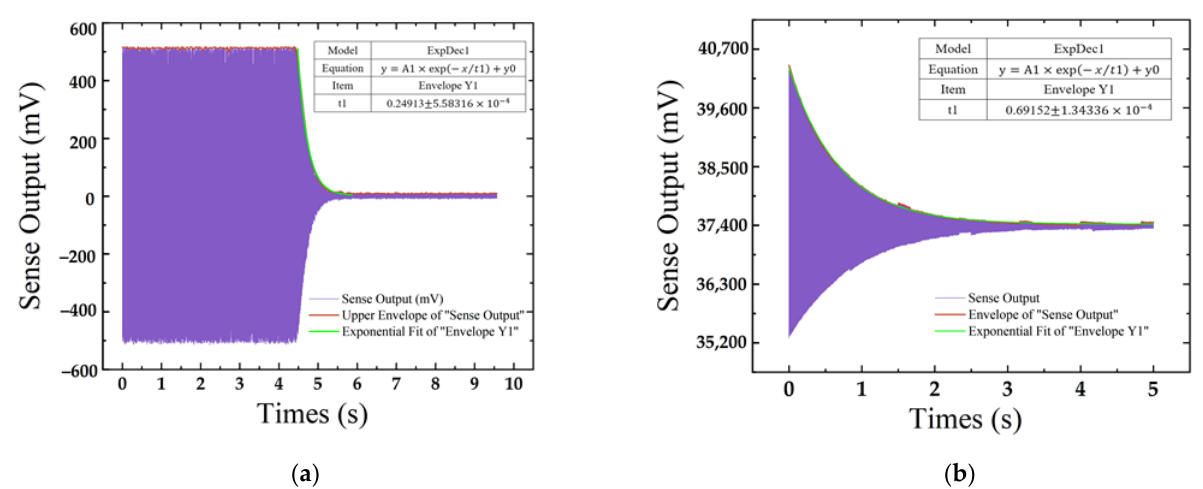
Figure 10. The time domain dynamic response measured in the sense mode of the gyroscope: ( a ) ceramic shell package; ( b ) novel 3D package.